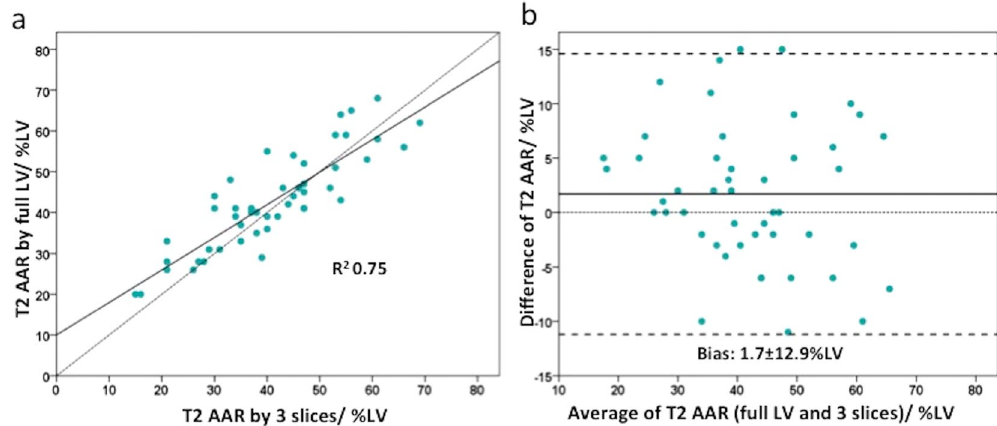
Figure 1. Performance of the full LV coverage versus 3-slice approach for the T2-based AAR. ( a ) The correlation between the 2 approaches; ( b ) The Bland-Altman plot.